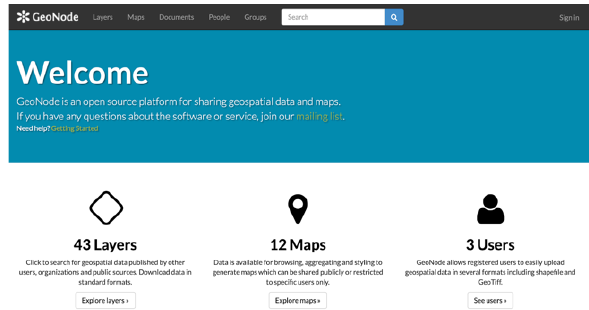
Figure 4. Default interface of GeoNode where geospatial data and web services, layers and interactive maps, are accessed, uploaded, managed and shared. Collaboration with other users is also